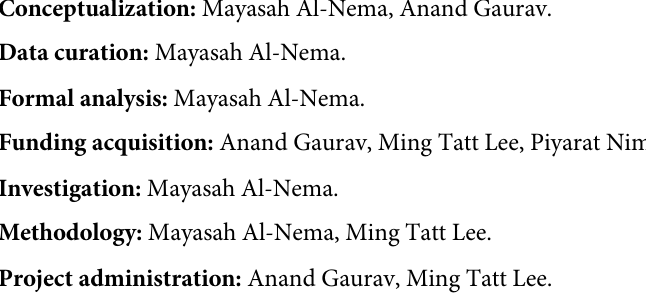
S1 Table. Acute oral toxicity record sheet for the vehicle and compound 2 treated rats. S2 Table. Serum biochemistry parameters of the vehicle and compound 2 treated rats in acute oral toxicity